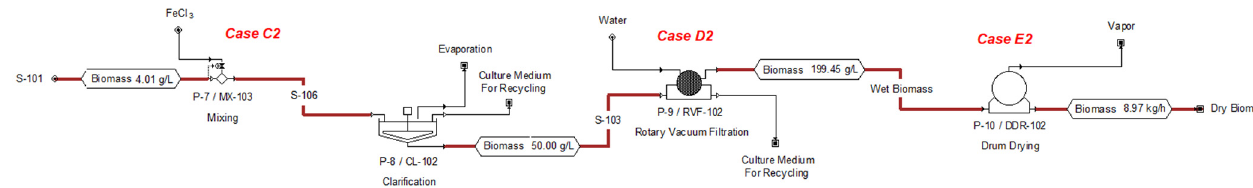
Figure 3. Flowsheet for the harvesting section (primary and secondary) and drying stage, of scenario 1 (case C, D and E).